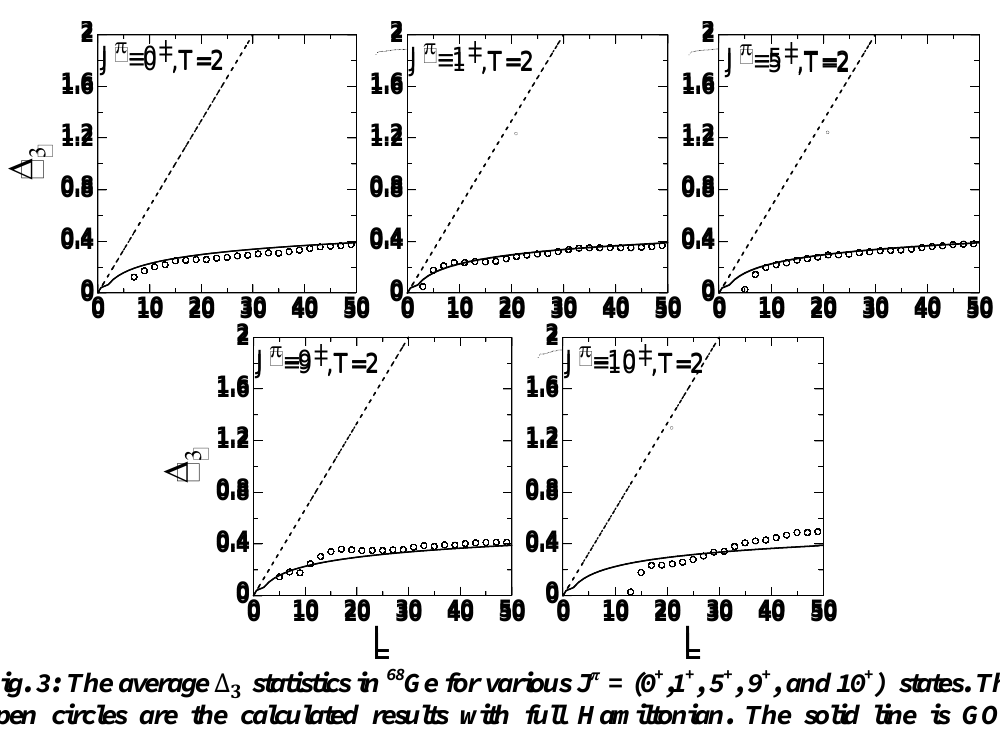
Fig. 3: The average statistics in 68 Ge for various J π = (0 + ,1 + , 5 + , 9 + , and 10 + ) states. The open circles are the calculated results with full Hamiltonian. The solid line is GOE ∆ 𝟑 distribution and dash line is the Poisson